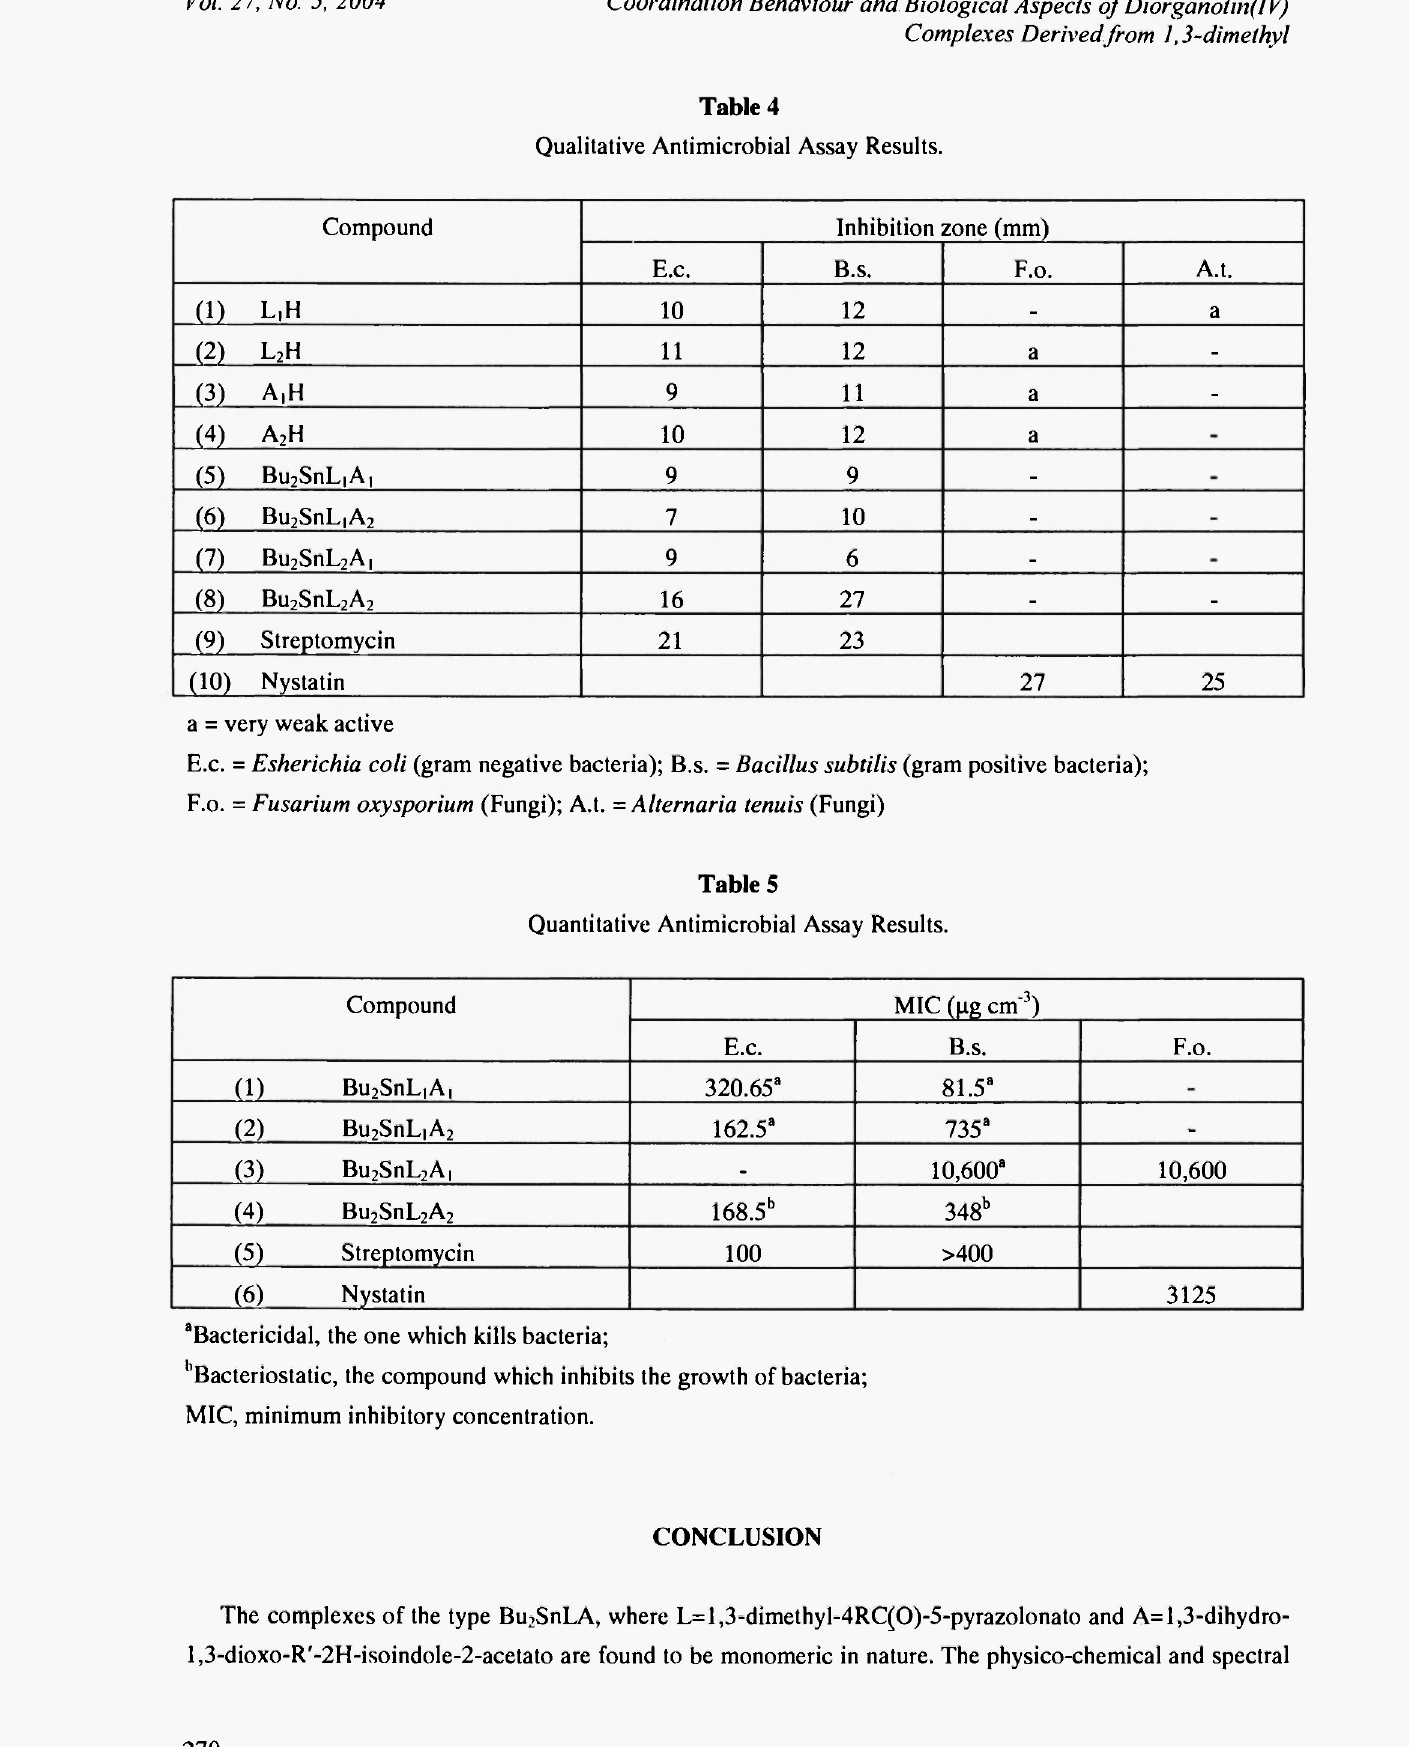
Quantitative Antimicrobial Assay